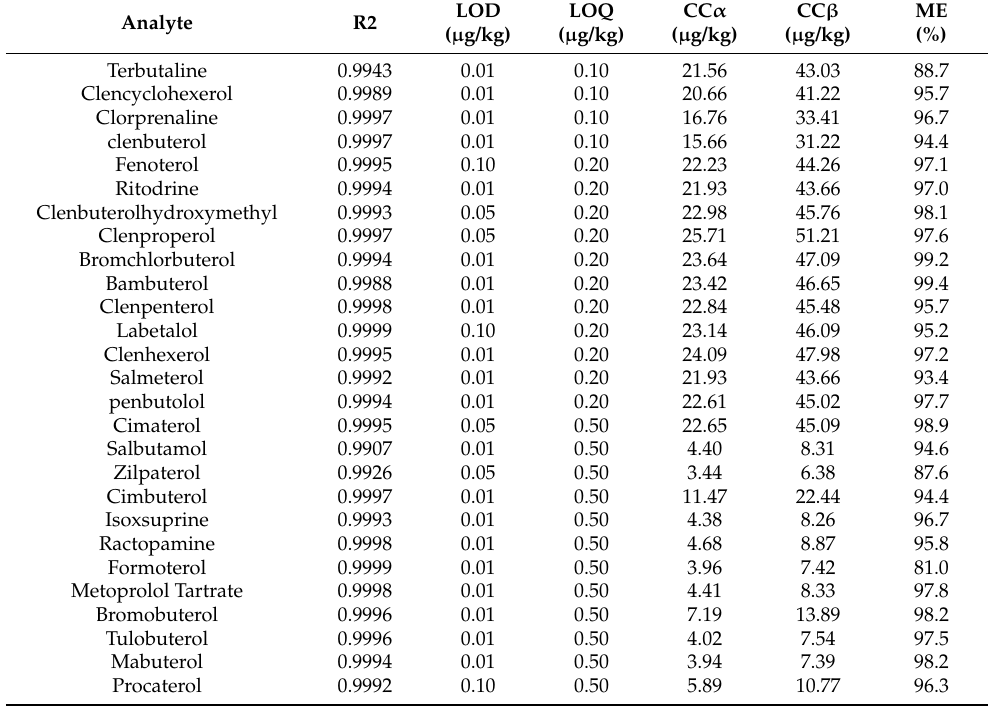
Table 2. Statistical and performance characteristics of the proposed UHPLC–MS/MS method for beta-agonists analysis in pork samples according to the applied sample